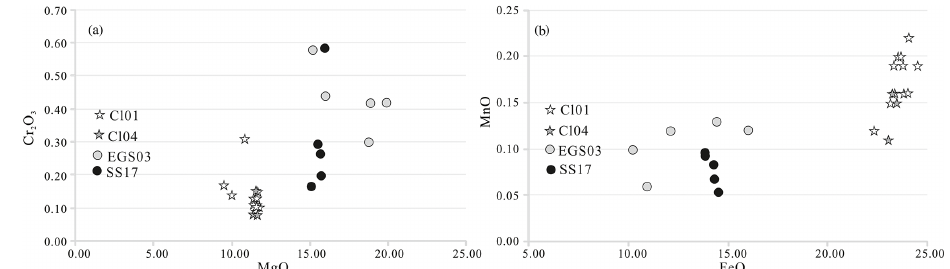
Figure 4. Diagrams of Cr 2 O 3 versus MgO and MnO versus FeO showing systematic compositional variations in the Changle rhönites.